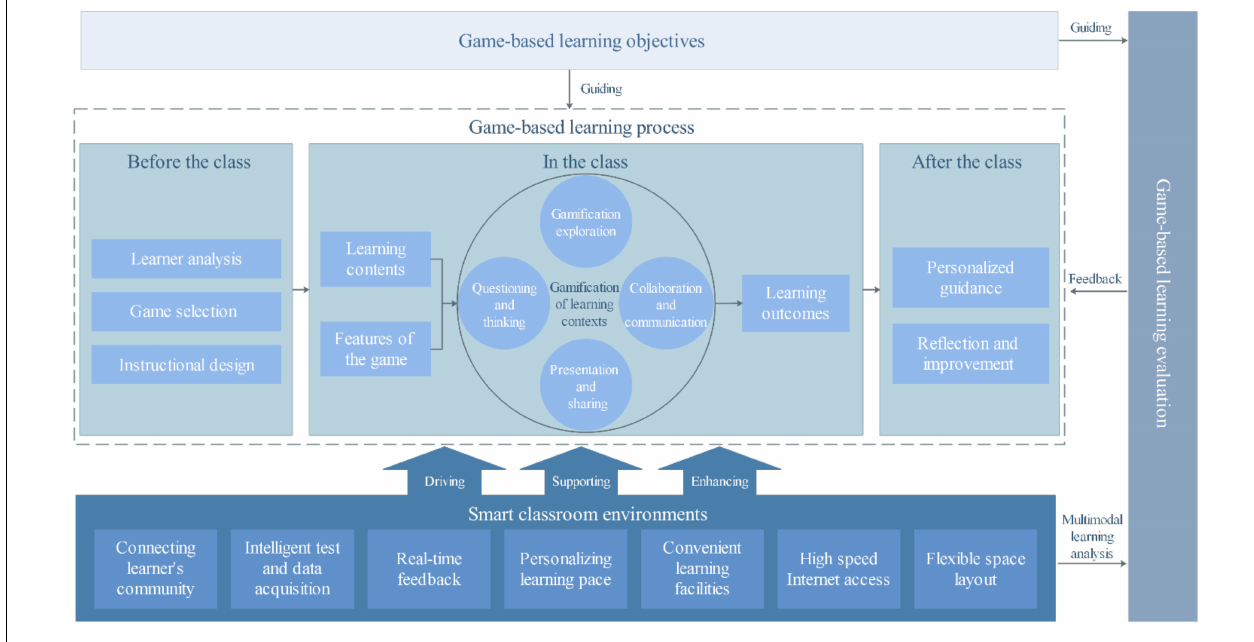
FIGURE 2 | The technology enhanced GBL